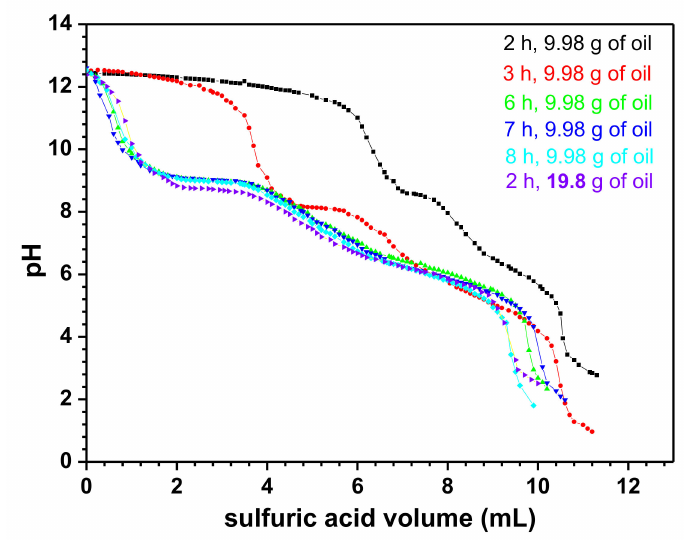
Figure 1. The pH-metric titration curve between obtained carboxylate solution and sulfuric acid solution.